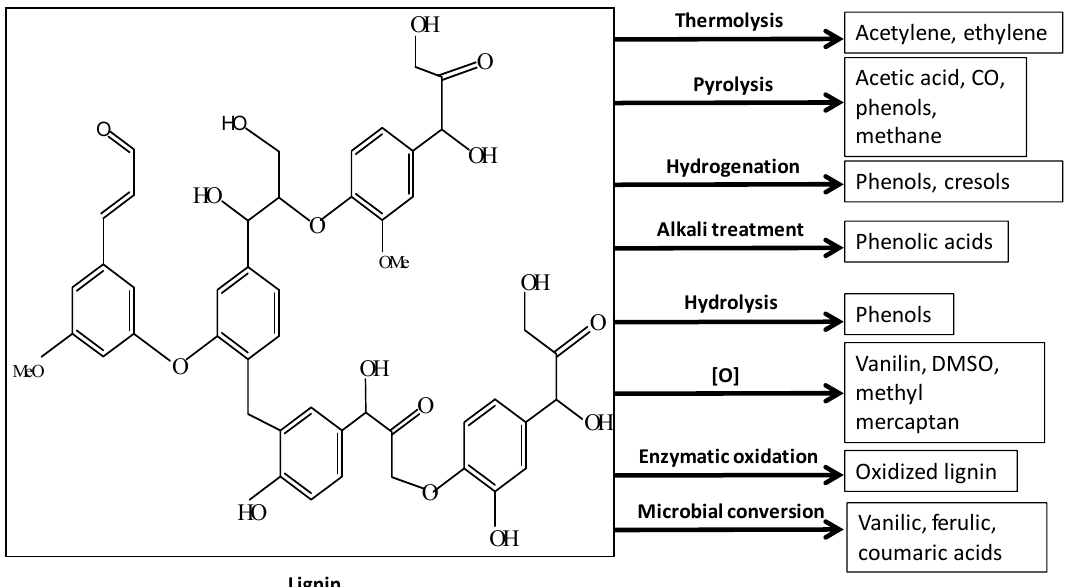
Figure 14. Chemical transformations of lignin and their products [270–272].